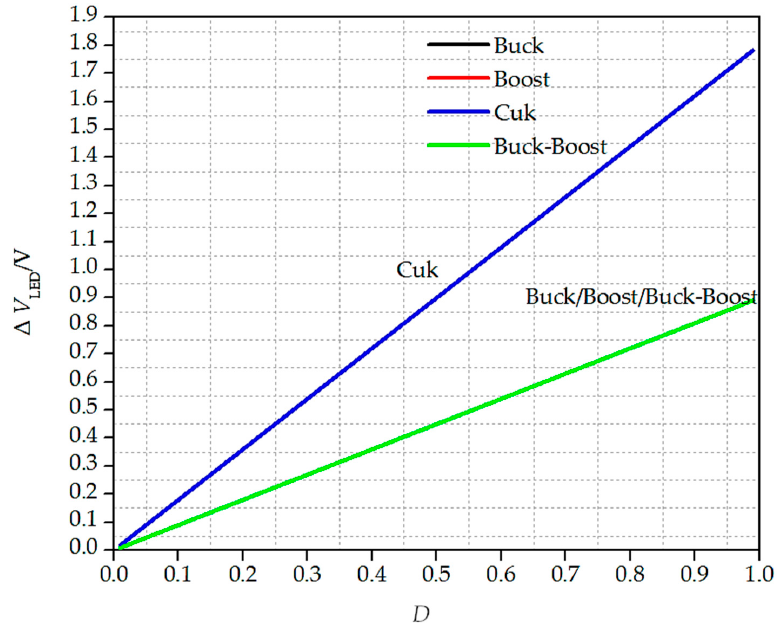
Figure 14. Relationship between voltage ripple magnitude and D of the LED in diode converters. Using the same parameters, according to Table 2, the voltage ripple magnitude of the LEDs in transistor converters is plotted in Figure 15. It can be seen from Figure 15 that the voltage ripple magnitude increases linearly with D for boost and buck–boost converters and the curves of buck and Ć uk converters are just like a parabola structure. The voltage ripple magnitude of the LED driven by